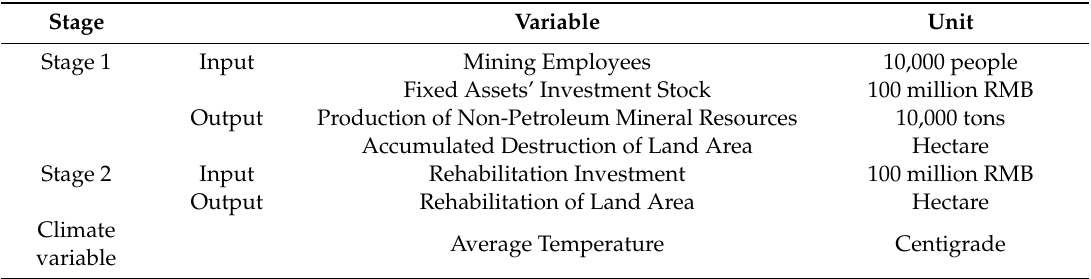
Table 1. Input and output